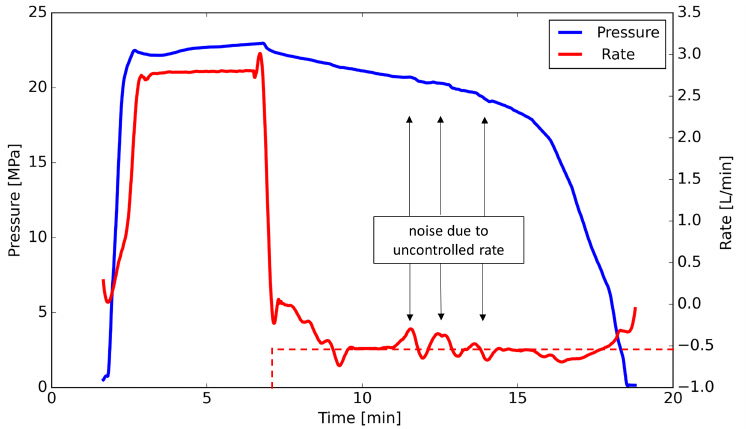
Figure 15. Cycle 2.2 flowback